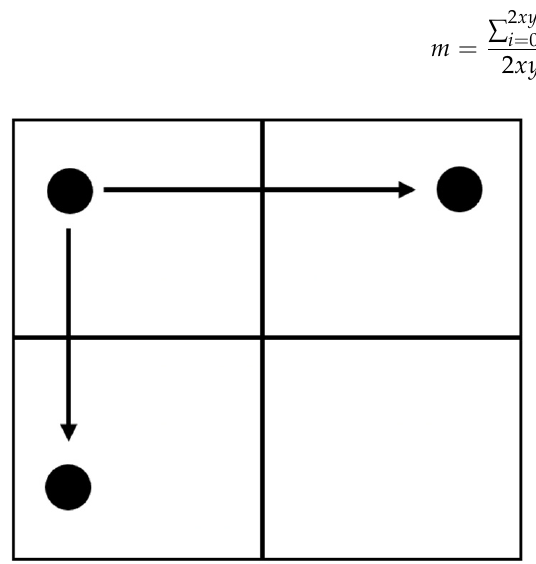
Figure 2. Symmetry calculation.